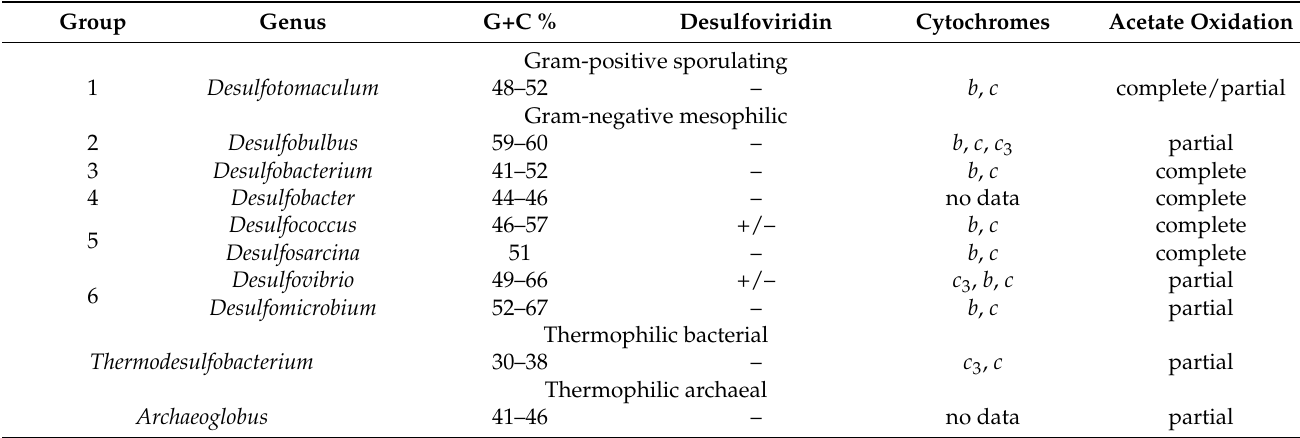
Table 4. Groups of SRB based on rRNA sequences with their representatives and important molecular and biochemical characteristics (data taken from Castro et al. and Daly et al.